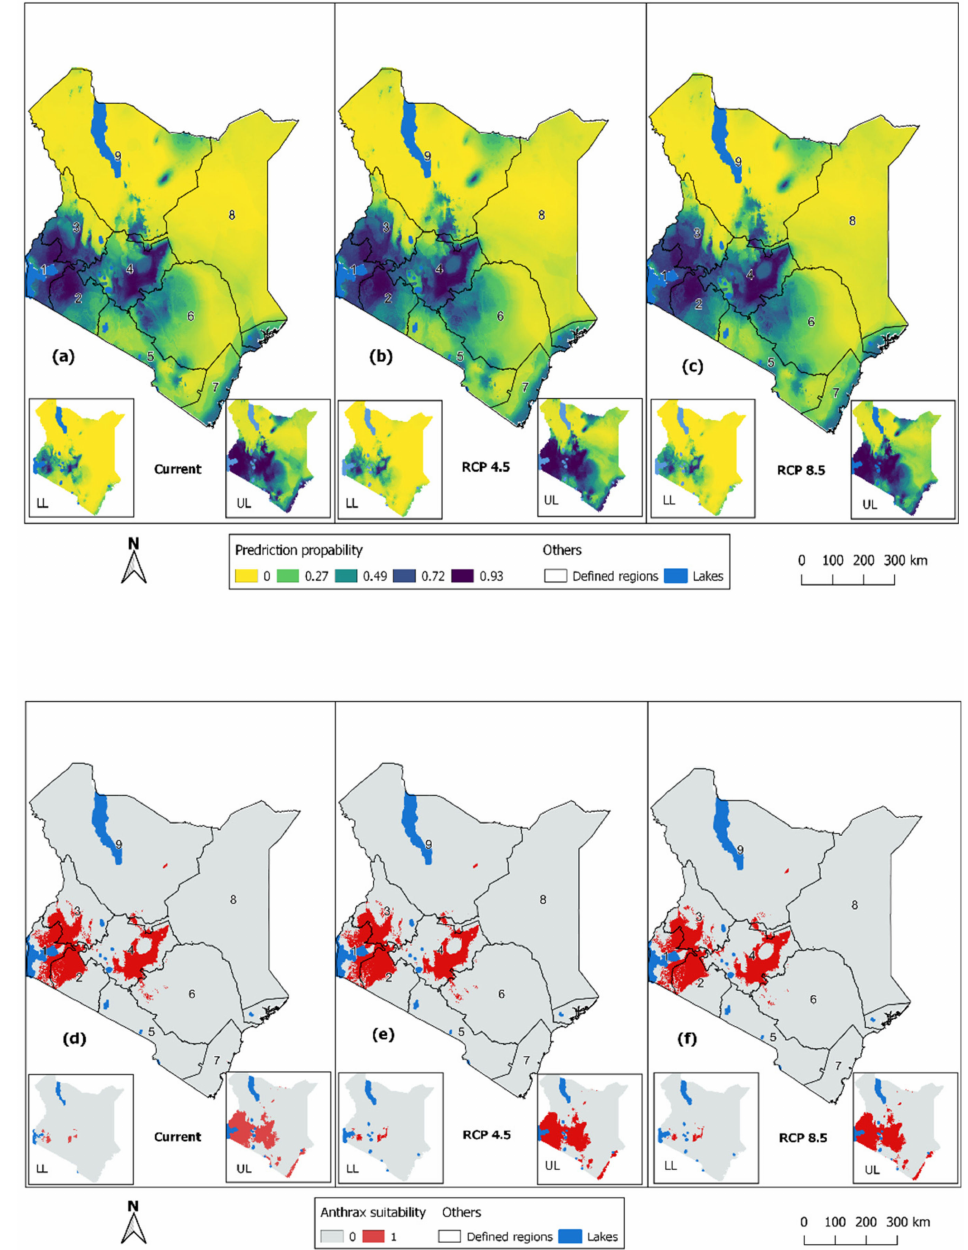
Figure 2. Potential distribution predictions for anthrax occurrence in Kenya for climate scenarios: ( a ) the current climate; ( b ) future RCP 4.5; ( c ) Dichotomized predictions of anthrax suitability using the Youden index ( ≥ 0.75) for climate scenarios: ( d ) the current climate; ( e ) future RCP 4.5; ( f ) RCP 8.5. Inset maps for each panel show the lower (2.5%; left ) and upper (97.5%; right ) confidence intervals of predictions. Codes 1–9 indicate arbitrarily defined regions to represent important regions for describing the predicted distribution of anthrax: (1) Lake Victoria basin; (2) Southwestern; (3) Southern; (4) Western; (5) Central; (6) Eastern; (7) Coastal; (8) Northeastern; (9)